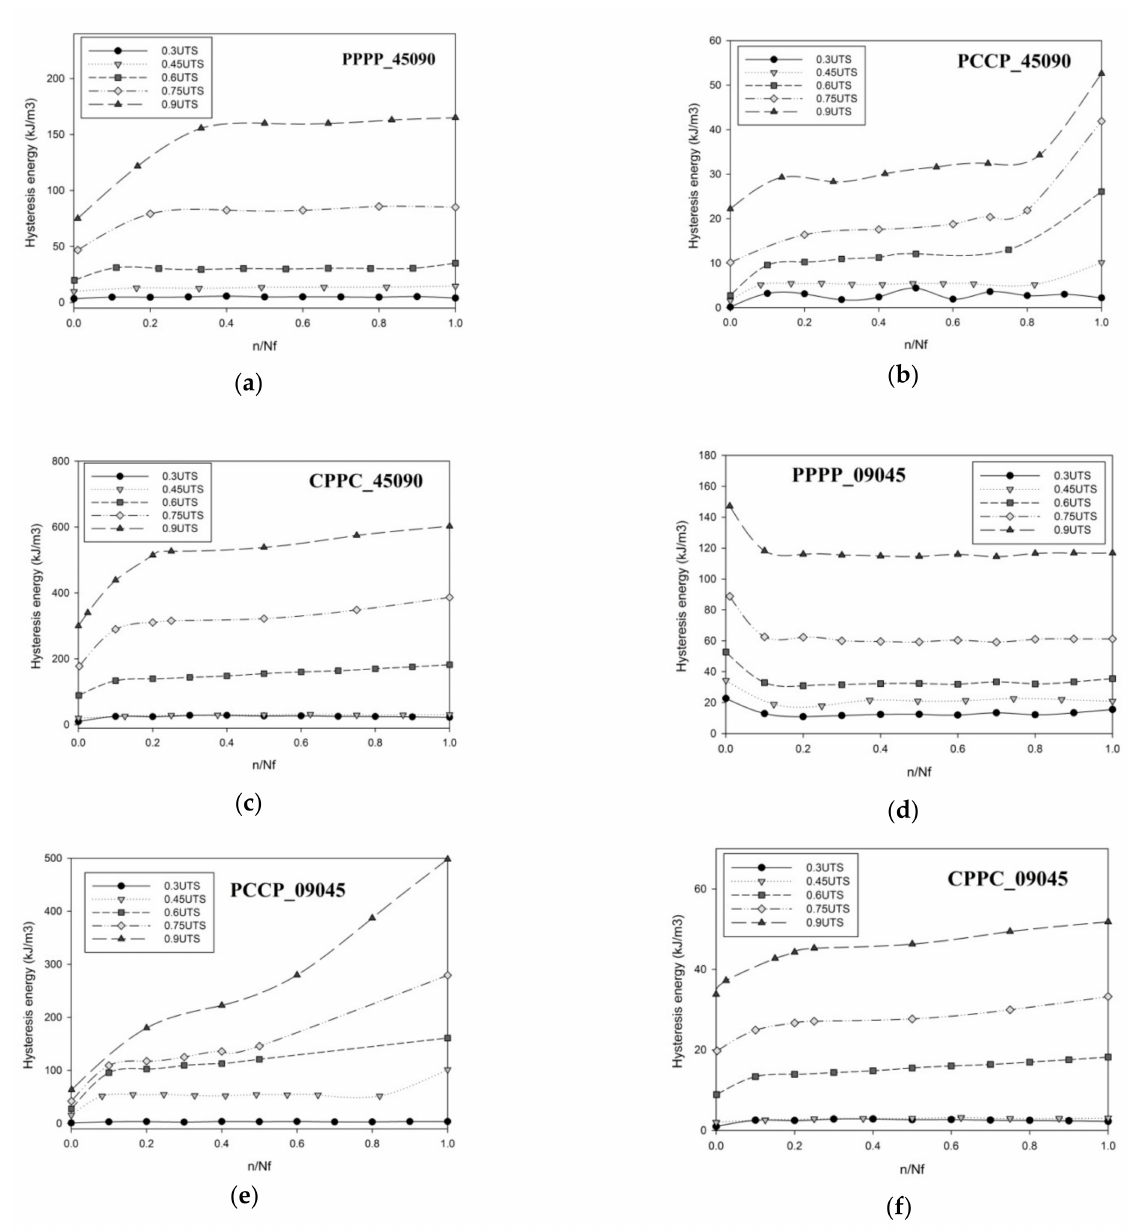
Figure 5. Hysteresis energy for the laminates produced in this study; ( a ) PPPP_45090, ( b ) PCCP_45090, ( c ) CPPC_45090, ( d )PPPP_09045, ( e ) PCCP_09045 and ( f ).